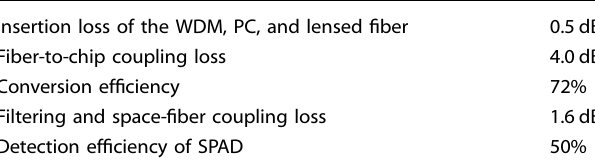
Table 1. Insertion losses or ef fi ciencies of the